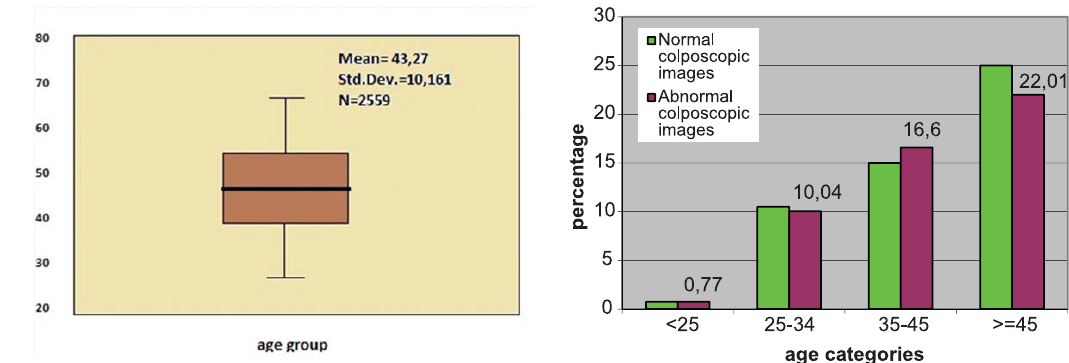
FIGURE 2. The age distribution histogram. The age distribu- tion histogram shows the normal age distribution in the sam- ple with Mean -43.27 and SD-10.16. The youngest analyzed patient was 21 years old and the oldest 78 years.